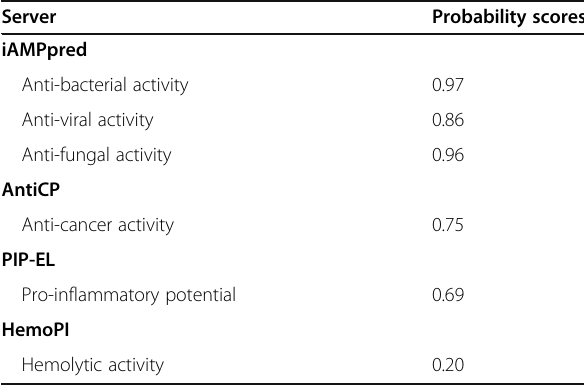
Table 1 Probability scores predicted based on SVM algorithm of the respective web-based